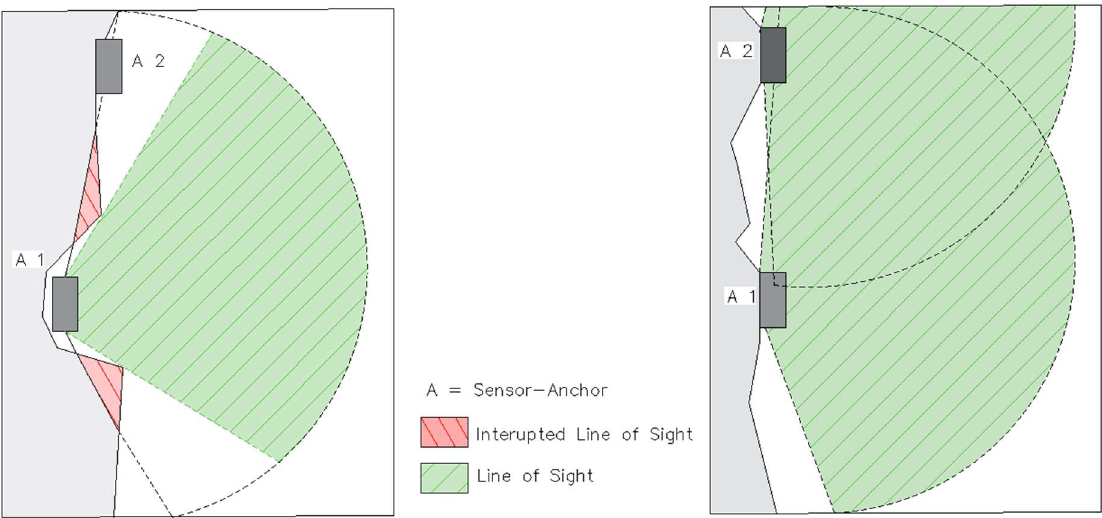
Figure 2. Depictured are Sensor Anchors A1 and A2 in different scenarios, on the left side is interrupted Line of Sight whereas on the right side we have clear Line of Sight from A1 to A2.